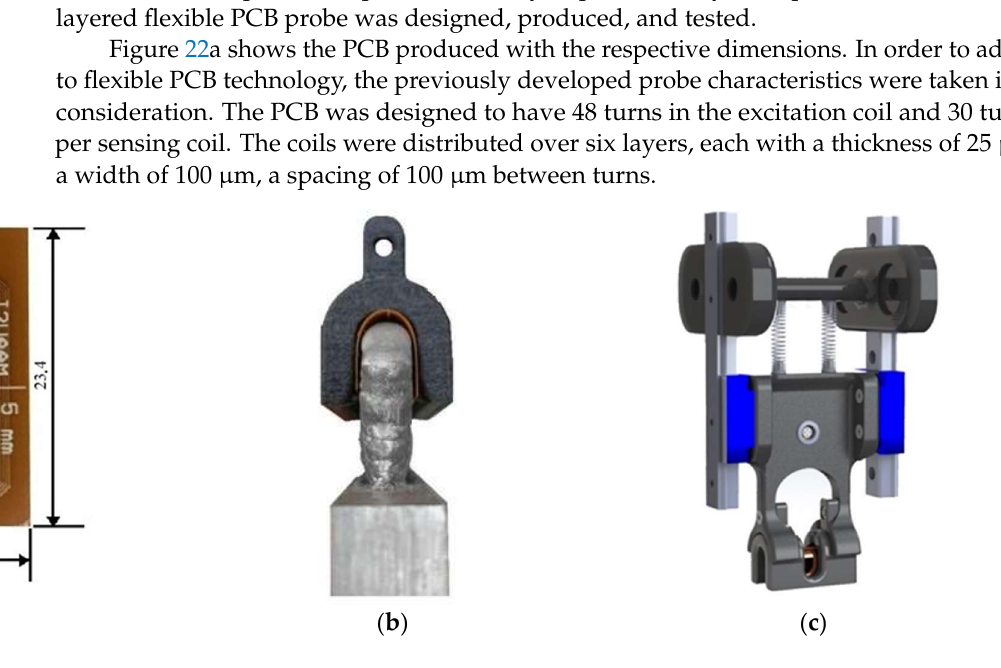
Figure 22. Multi-layer flexible PCB probe; ( a ) PCB; ( b ) PCB assembled in the TPU chassis mounted over a WAAM wall specimen; ( c ) complete probe set-up system.